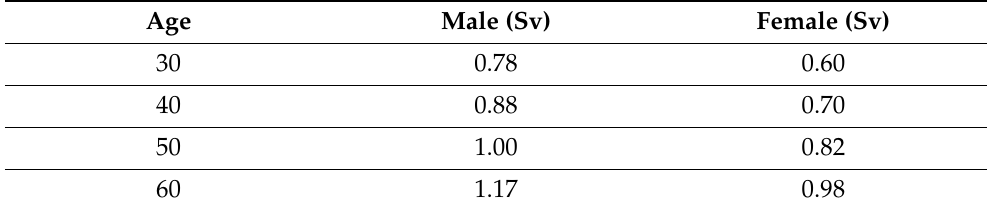
Table 1. Effective-dose career limits based on the NASA Space Cancer Risk 2012 model for 1-year missions